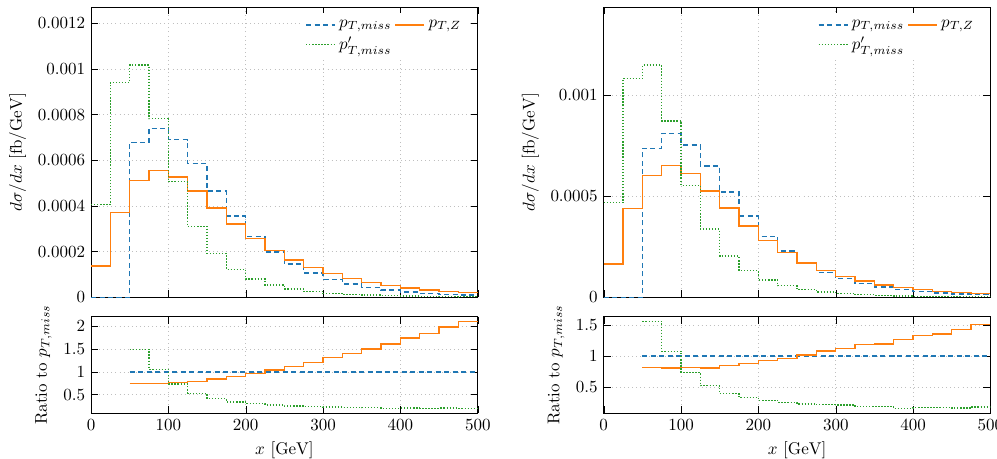
Figure 11 . The pp e + (cid:23) e (cid:22) (cid:0) (cid:22) (cid:23) (cid:22) b (cid:22) b (cid:23) (cid:28) (cid:22) (cid:23) (cid:28) + X LO (left panel) and NLO (right panel) di(cid:11)erential cross ! section distribution as a function of p miss , p T;Z and p 0 miss at the LHC run II with p s = 13 TeV. T T The upper plots show absolute QCD predictions. The lower panels present ratios to p miss . The T CT14 PDF sets and (cid:22) 0 = m t + m Z = 2 are employed.